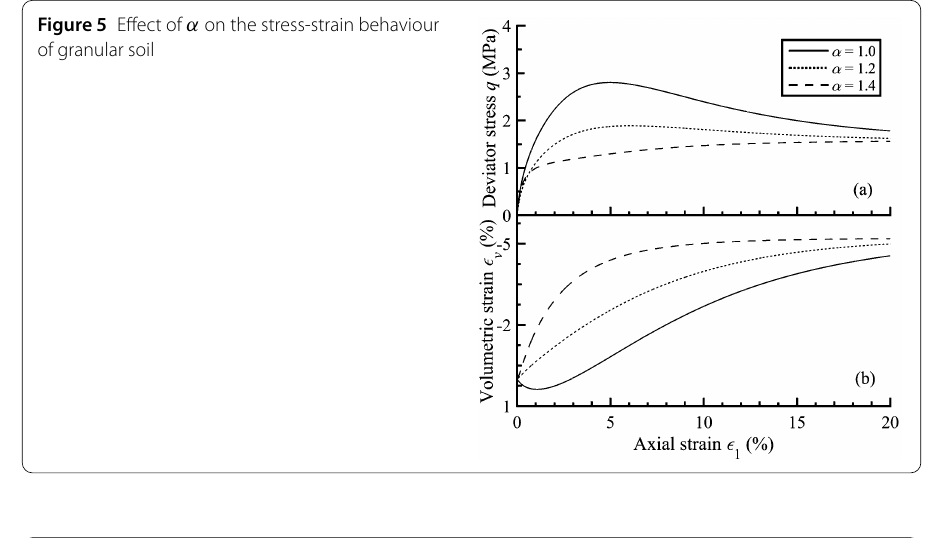
Figure 6 Effects of h 1 and h 2 on the stress-strain behaviour of granular